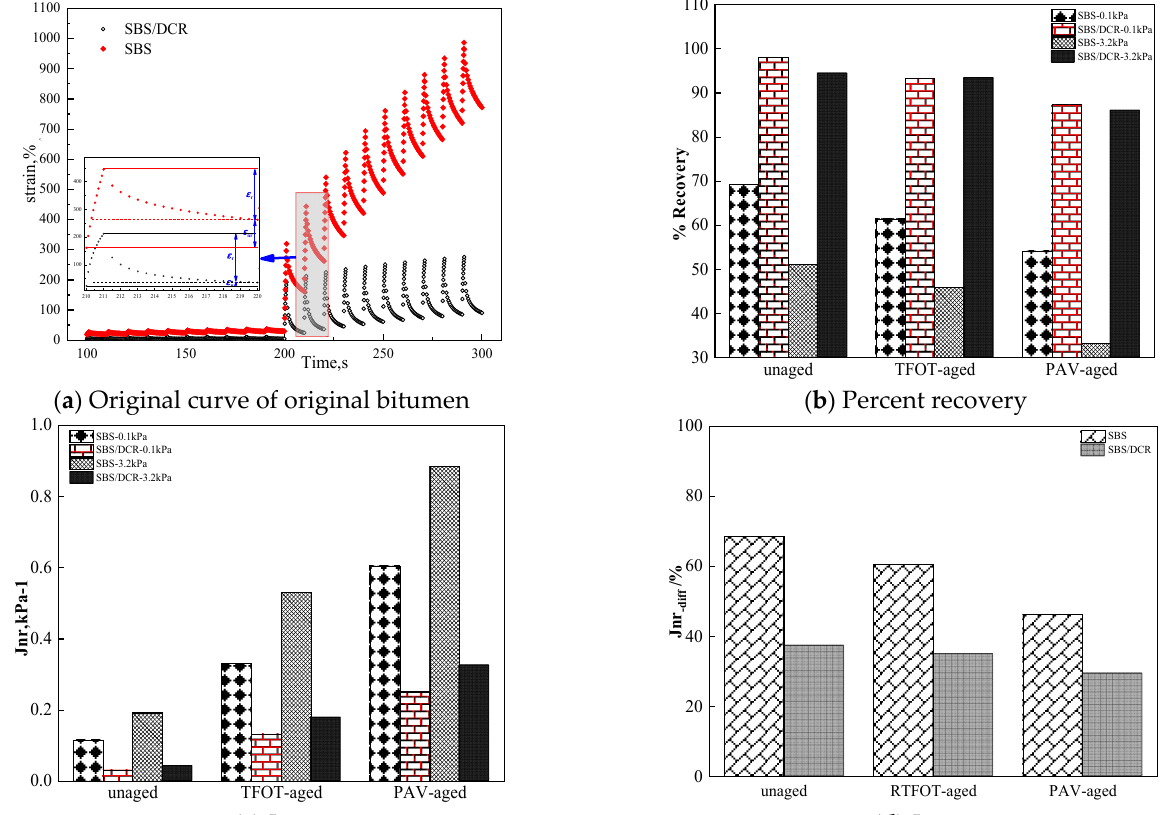
Figure 6. MSCR test result in different aging conditions of two modified bitumen.